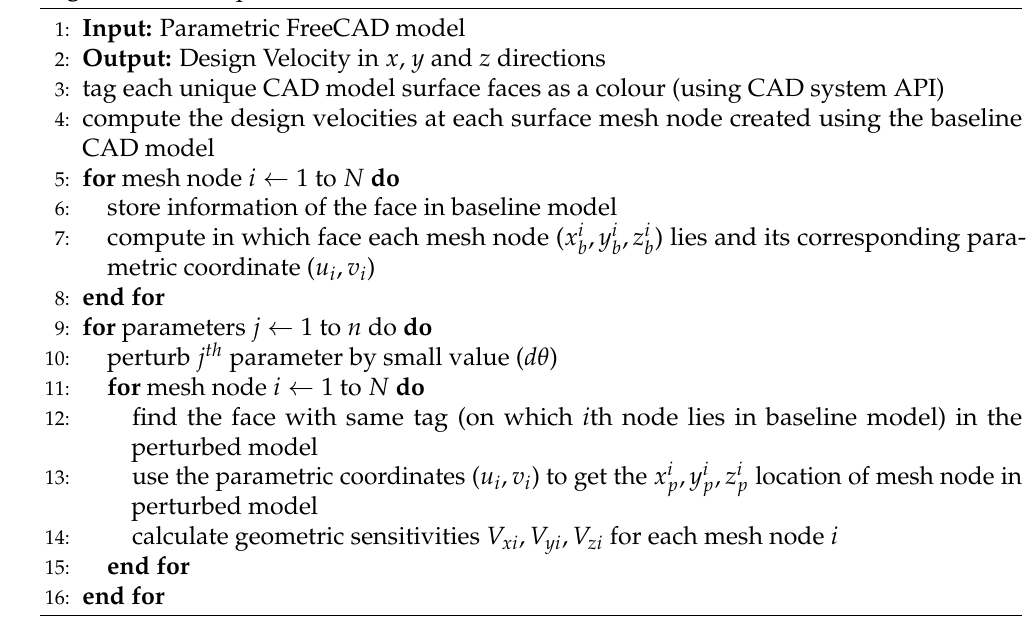
Figure 1. Computation of geometric sensitivities or design velocity: ( a ) box model showing baseline and perturbed geometry; ( b ) design velocity computed in normal direction ( V n ) using approach described in Ref. [9]; geometric sensitivities in ( c ) x direction and ( d ) y direction. Algorithm 1 Computation of Geometric